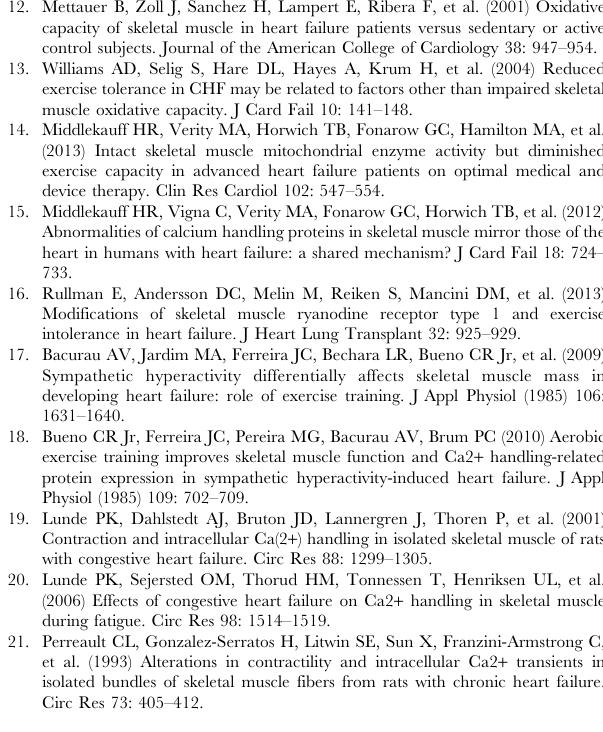
Figure S1 The transverse tubular system in live fibers from control and HF individuals. Muscle bundles